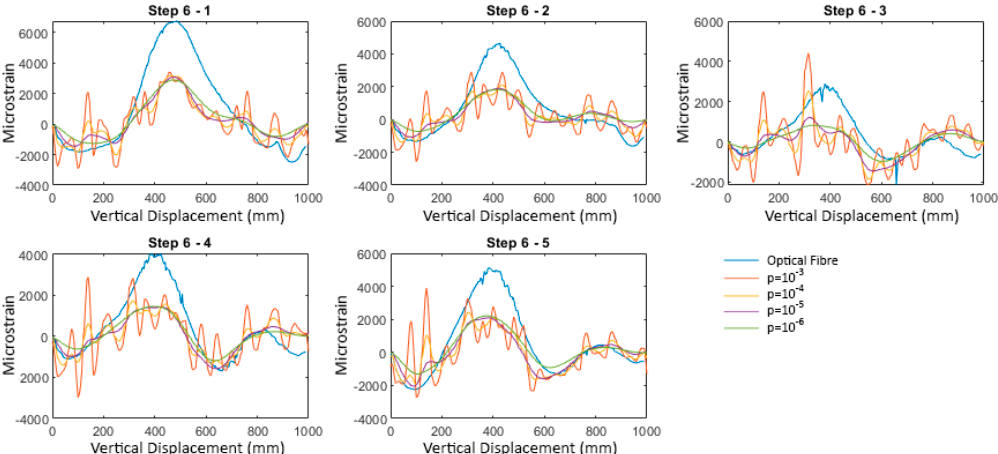
Figure 14. OOP deformation test: Change in strain of Step 6 relative to the preceding tests with different (cid:1868) and measured by the optical fibre along the vertical line at 1000 mm horizontally.